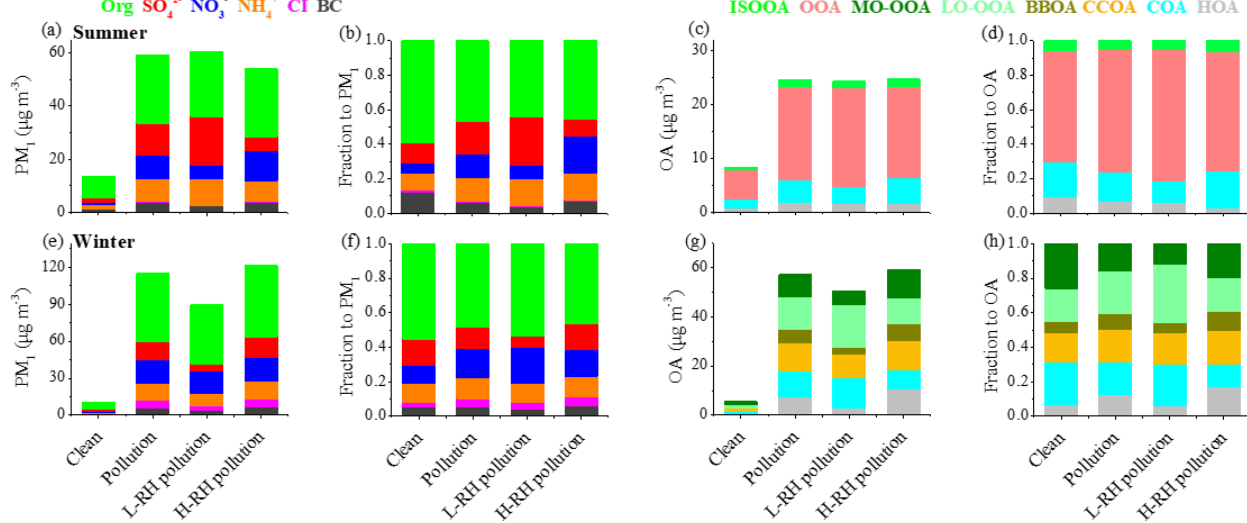
Figure 8. Mass concentrations and relative contributions of PM 1 species and OA sources during different periods in summer (a–d) and winter (e–h)